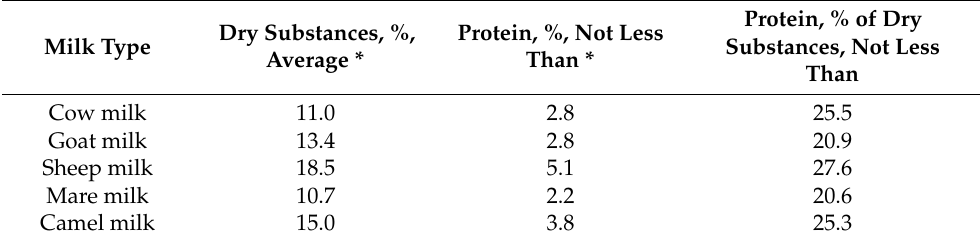
Table 7. Chemical composition of milk of different farm animals. (source: TR CU 033/2013 “On the safety of milk and dairy products”, * Russian Federation).